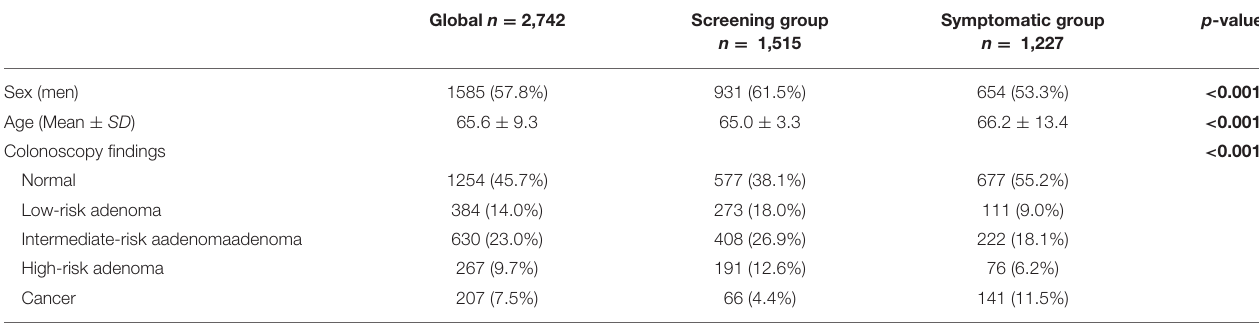
TABLE 1 | Demographics and colonoscopy findings according to FIT indication.